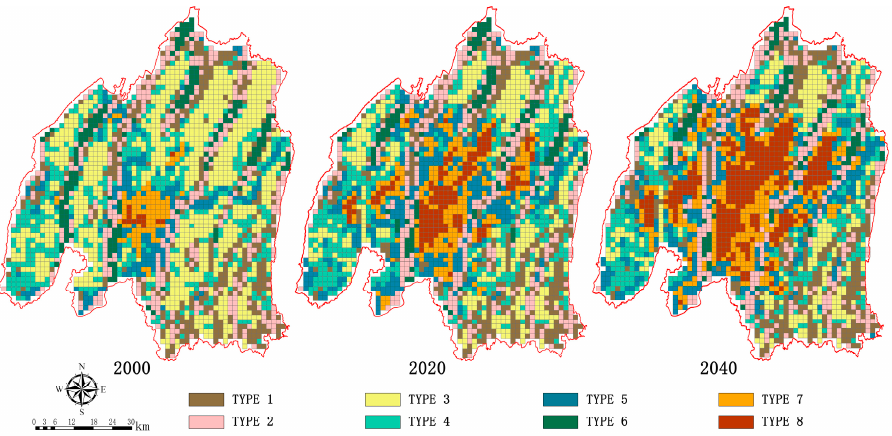
Figure 7. Spatial distribution of LCT in 2000, 2020, and 2040.